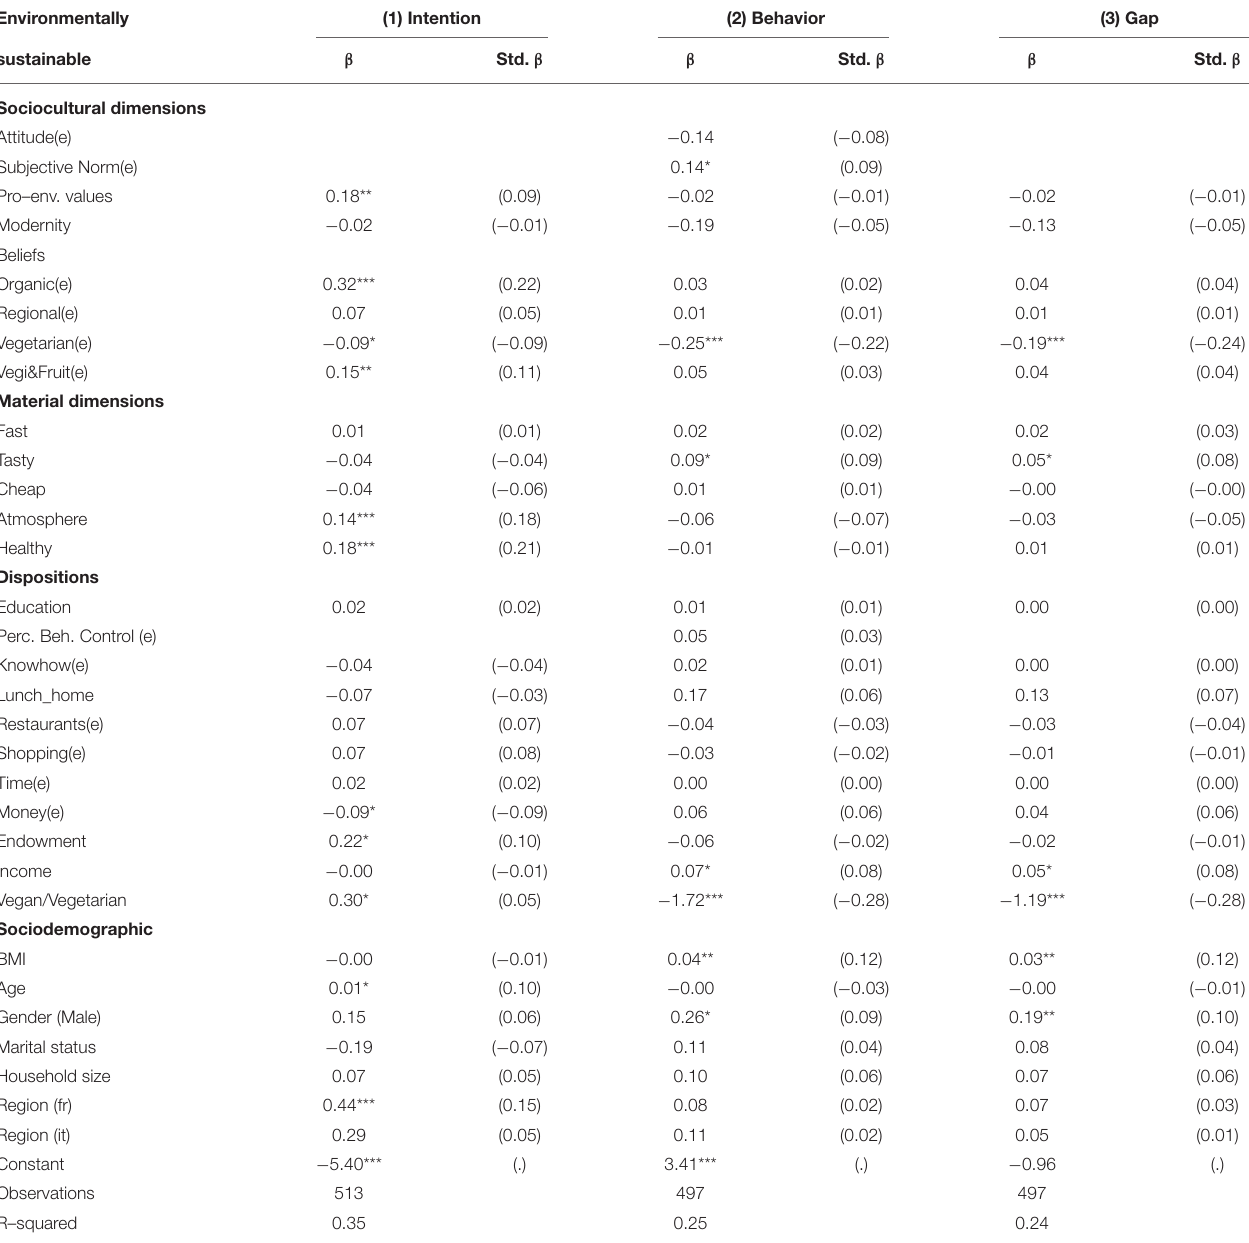
TABLE 5 | Regressions analysis explaining the intention, behavior, and the gap between the two regarding environmentally sustainable eating. Environmentally